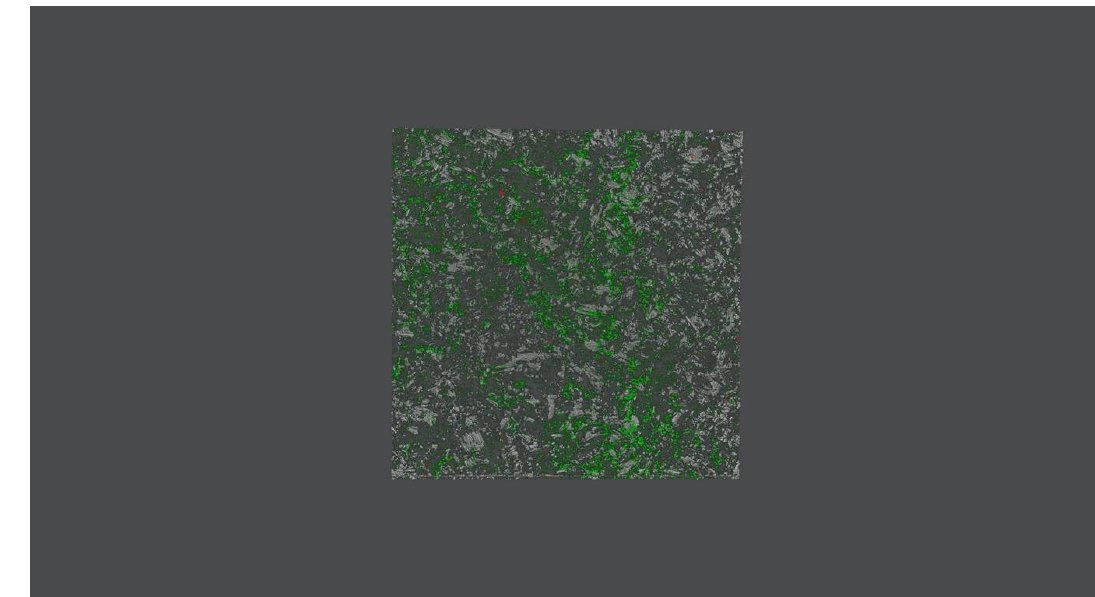
Figure 1. Two-dimensional depiction of a 72-h C. acnes biofilm grown on a titanium alloy disk using confocal laser microscopy (Leica model TCS SP5; Leica Microsystems CMS GmbH, Mannheim, Germany). Live bacteria are represented in green and dead cells in red.